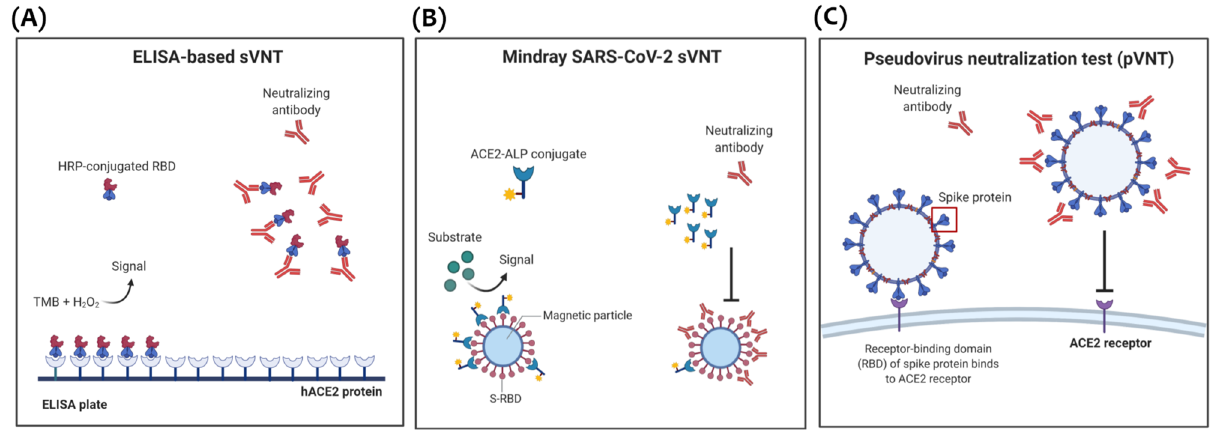
Figure 1. Graphical illustration for the principle of sVNT in comparison to pVNT. ( A ) Principle of ELISA- based surrogate virus neutralization test (sVNT) where anti-SARS-CoV-2 nAbs block the binding of HRP- conjugated RBD protein to the precoated hACE2 protein on the ELISA plate. ( B ) Principle of Mindray competitive binding NTAb immunoassay where anti-SARS-CoV-2 nAbs compete with the ACE2-ALP conjugate for RBD-binding sites on the magnetic beads. ( C ) Mechanism of pseudovirus neutralization test (pVNT) where anti-SARS-CoV-2 nAbs block the binding of SARS-CoV-2 spike (S) protein to human ACE2 receptor on the host cell surface. All illustrations were created using BioRender. Figures ( A ) and ( C ) were adapted from Wang et al. 7